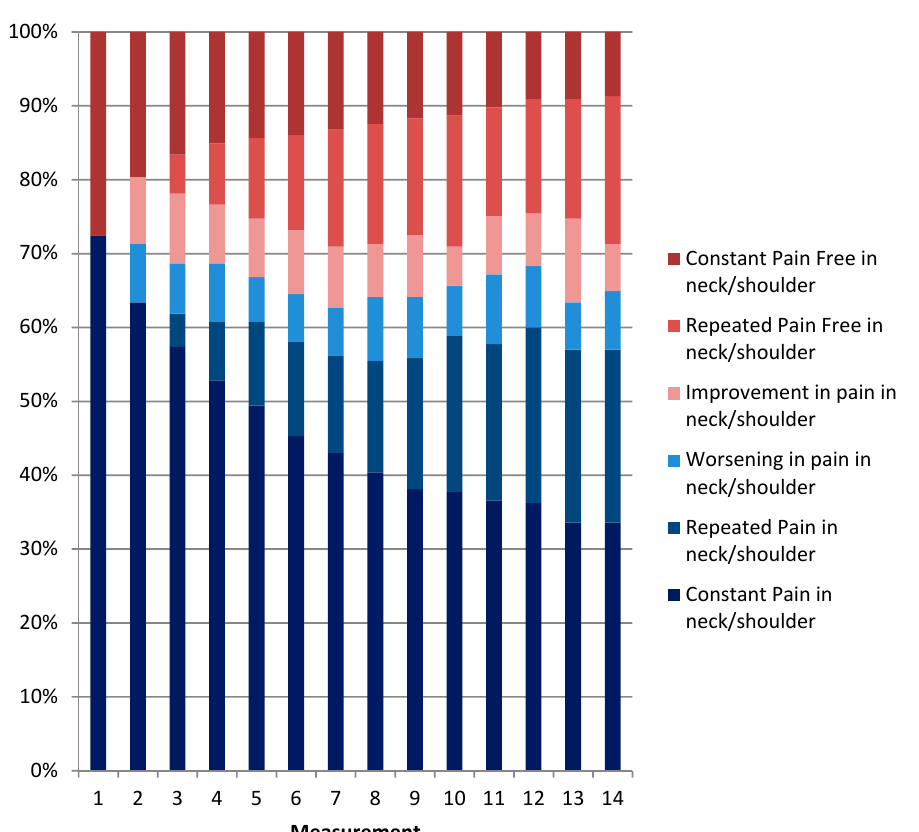
Figure 2. Patterns of low back pain episodes over one year.